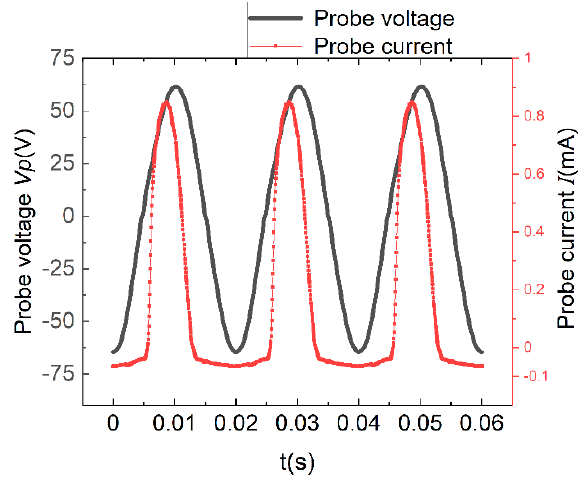
Figure 5. The voltage and current curve of the Langmuir probe with contamination.